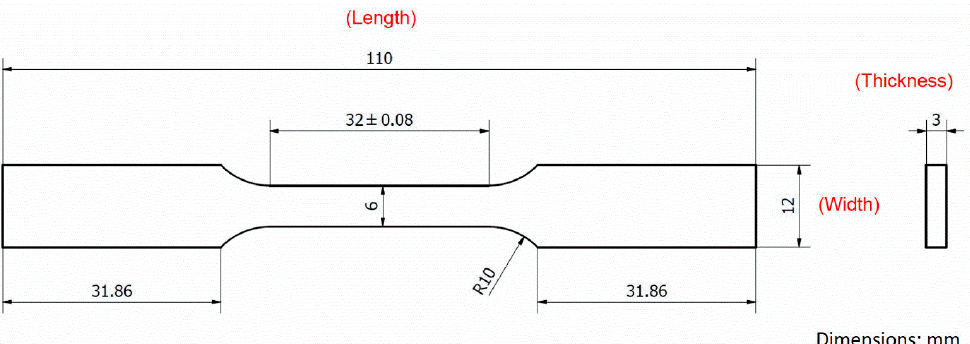
Figure 1. Geometry and dimensions of tensile specimen.